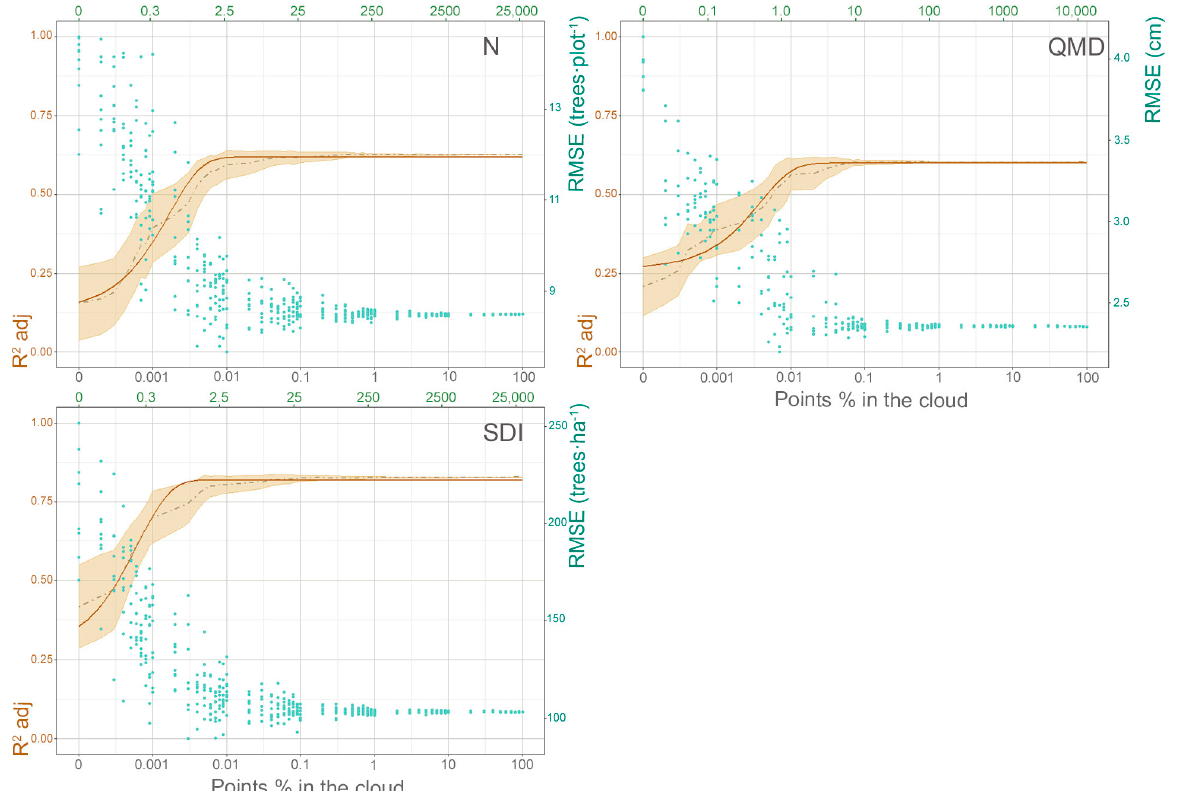
Figure 9. Variation in R 2adj and RMSE in the estimate of forest parameters AGB , BA , CBH , Hd , N , QMD , and SDI , with respect to the point density. The light brown area represents the standard deviation for the 10 test repetitions performed for each point density. The dashed gray curve represents the mean value of the point distribution. The brown curve represents the fitted model (negative exponential). The blue dots represent the RMSE values obtained for the 10 test repetitions performed for each point density.